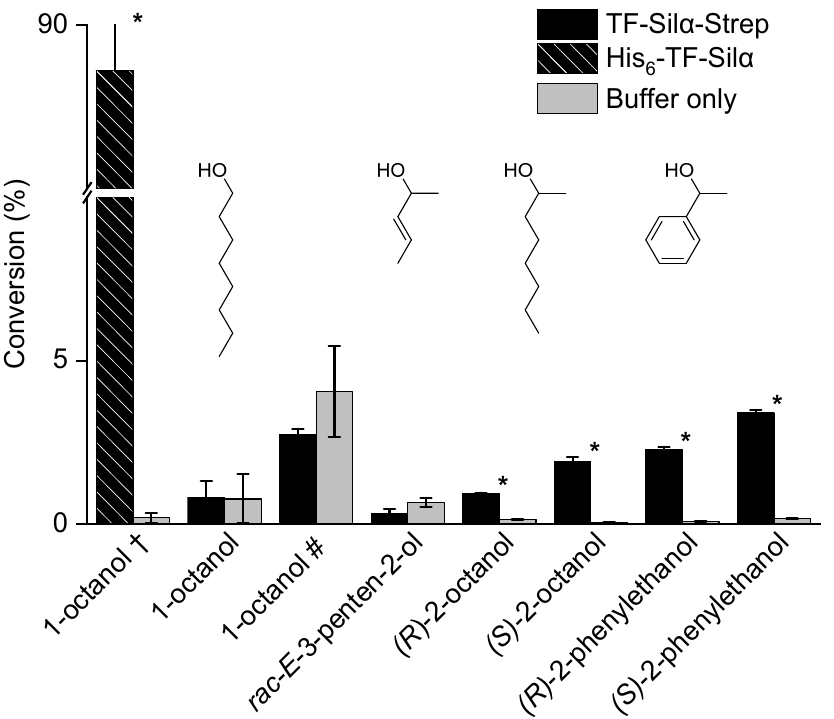
Figure 2. Graph of percentage conversions of alcohols to the corresponding silyl ethers after 72 h. The error bars indicate standard deviations. A one-tailed Student’s t -test assuming unequal variance was performed, comparing each enzyme to its control. Comparisons resulting in a p < 0.05 were deemed to be significant and are marked with *. The † indicates data for the hexahistidine-tagged enzyme taken from [20]. The # indicates a reaction time of 192 h. The structures of the alcohols are also shown inset.